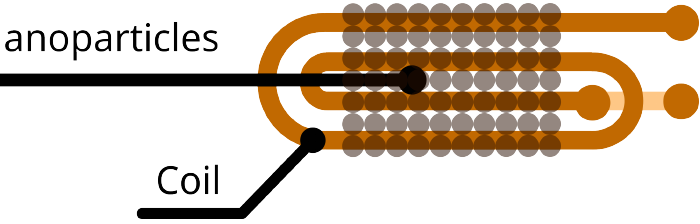
Figure 1. Representation of the sensing coil used in this work and sample